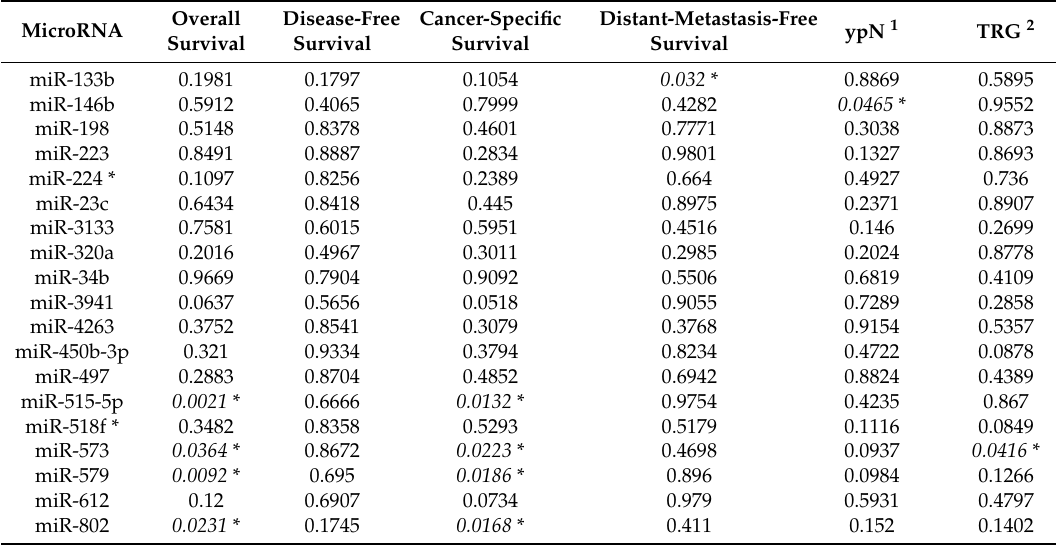
Table 1. p -values of the 19 microRNAs concerning correlation to the clinical